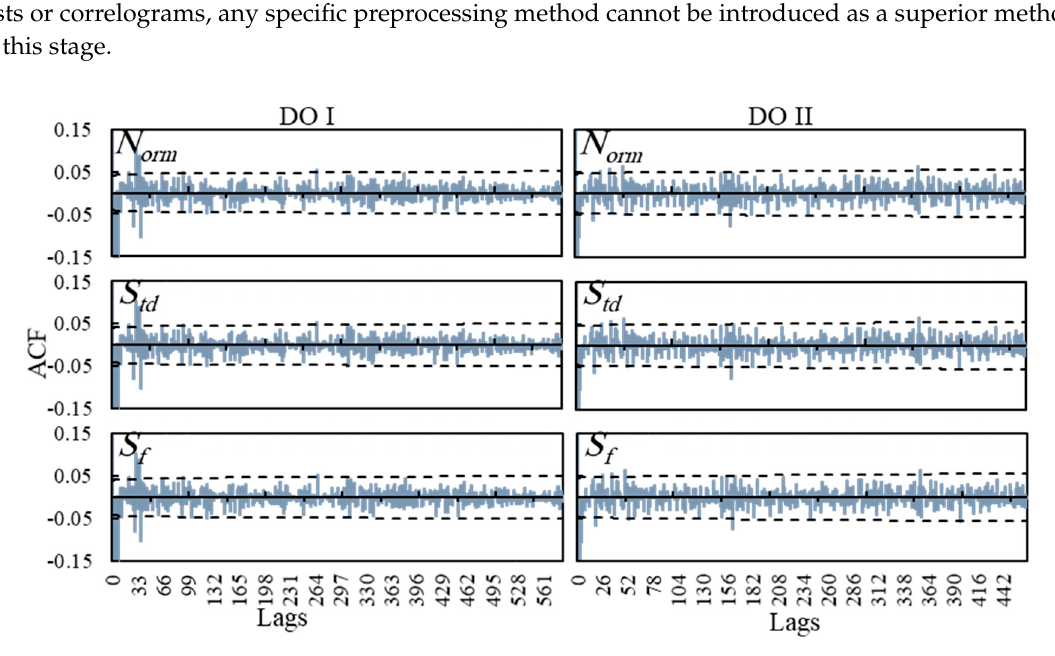
Table 4. Modeling evaluation indices of DO data. Superior Models